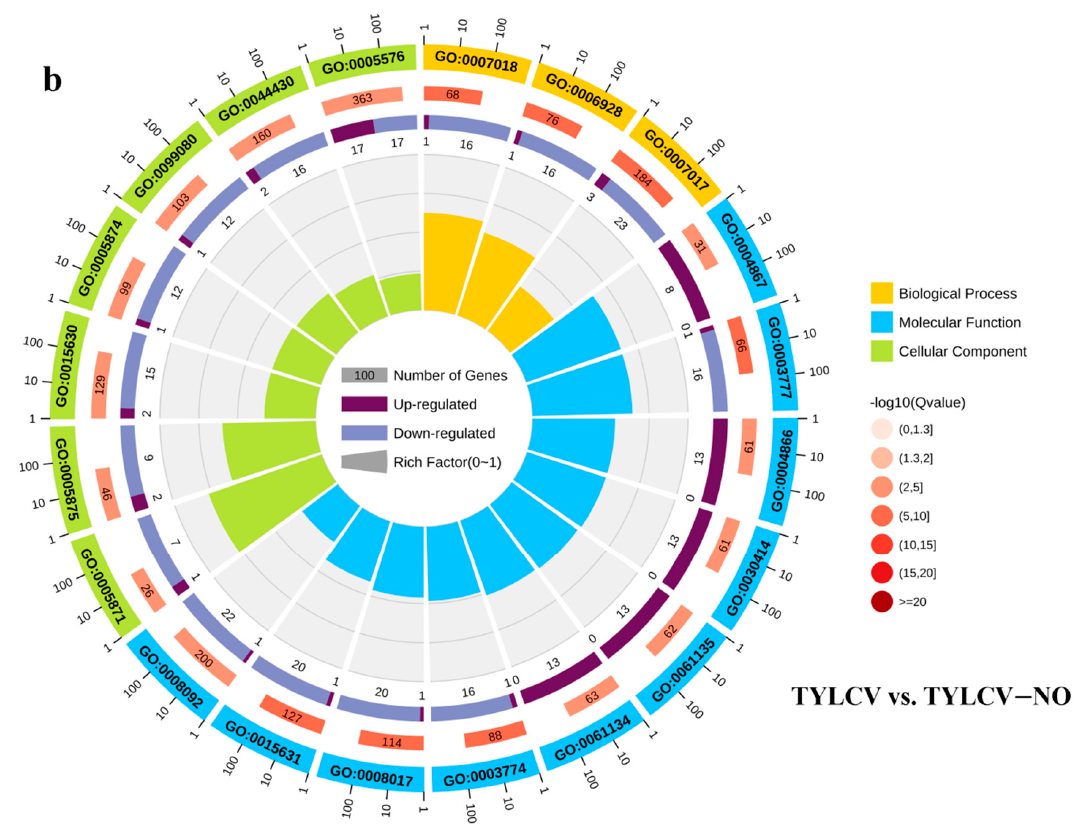
Figure 3. GO enrichment analysis of DEGs in tomato leaf responsive to TYLCV and susceptible tomato responsive to exogenous NO. ( a ) GO enrichment analysis of negative control and positive control producing DEGs. ( b ) GO enrichment analysis of DEGs generated in positive control and treatment groups. The first circle indicates the GO term, and the outside of the circle is the sitting scale of DEGs. Different colors represent different ontologies; the second circle is the number of this GO term in the background of DEGs and the Q-value; the third circle is the bar graph of the proportion of up- and down-regulated differential genes; dark purple represents the proportion of up-regulated DEGs, light purple represents the proportion of down-regulated DEGs; the specific values are shown below; the fourth circle is the RichFactor value of each GO